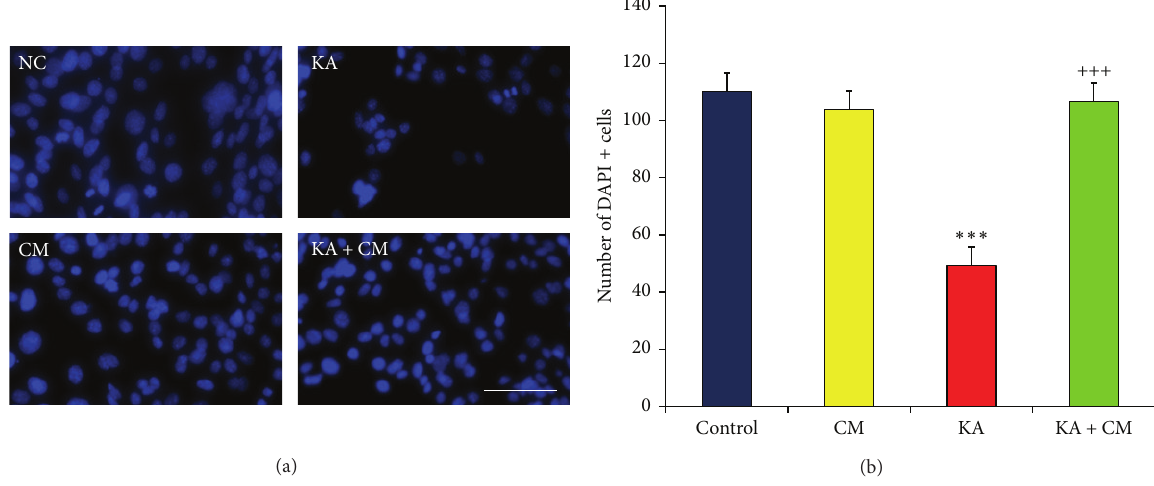
Figure 2: HEK-CM protects neurons. (a) Photomicrograph of DAPI + cells representing cell density in different treatment groups. (b) Bar diagrams representing the number of viable cells as quantified by DAPI + cells. Scale Bar 200 𝜇 m. Normal control (NC), normal control exposed to HEK conditioned medium (CM), Kainic acid alone treated (KA), and Kainic acid and HEK conditioned medium cotreated (KA + CM). Data represented as mean ± SEM. ∗ indicates comparison between NC and treatment; + indicates comparison between KA lesion and treatment; ∗∗∗ 𝑃 < 0.001 ; +++ 𝑃 < 0.001